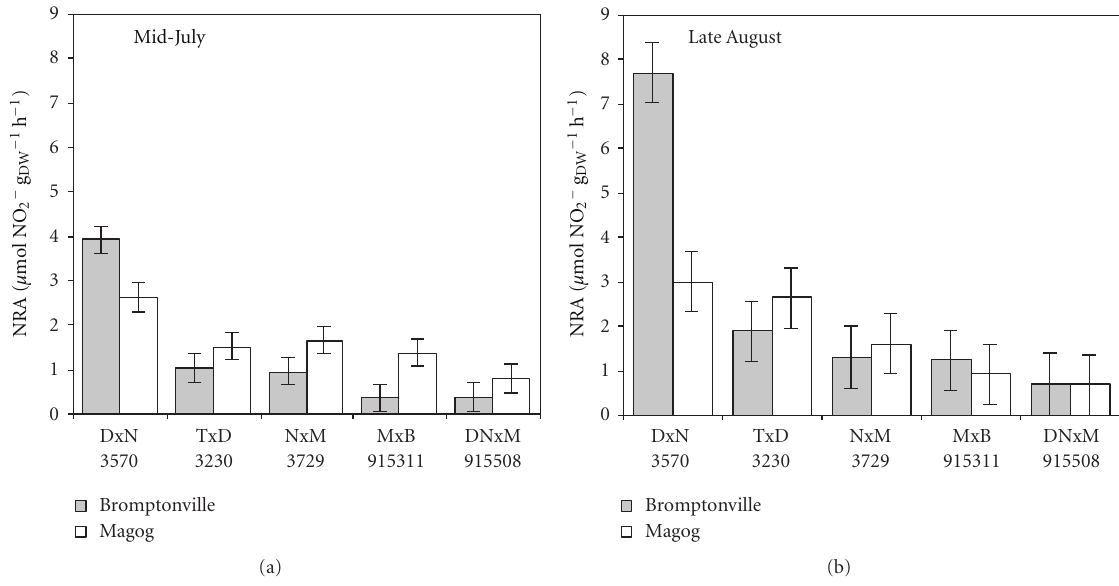
Figure 4: Nitrate reductase activity (NRA) of the five hybrid poplar clones at the two riparian bu ff er sites. On the left (a), the NRA assay was done in mid-July (July 10 and 11, 2007) and Site x Clone interaction is significant at P < 0 . 05. On the right (b), NRA assay was done in late August (August 28 and 29, 2007) and Site x Clone interaction is significant at P < 0 . 01. Vertical bars represent SE of the